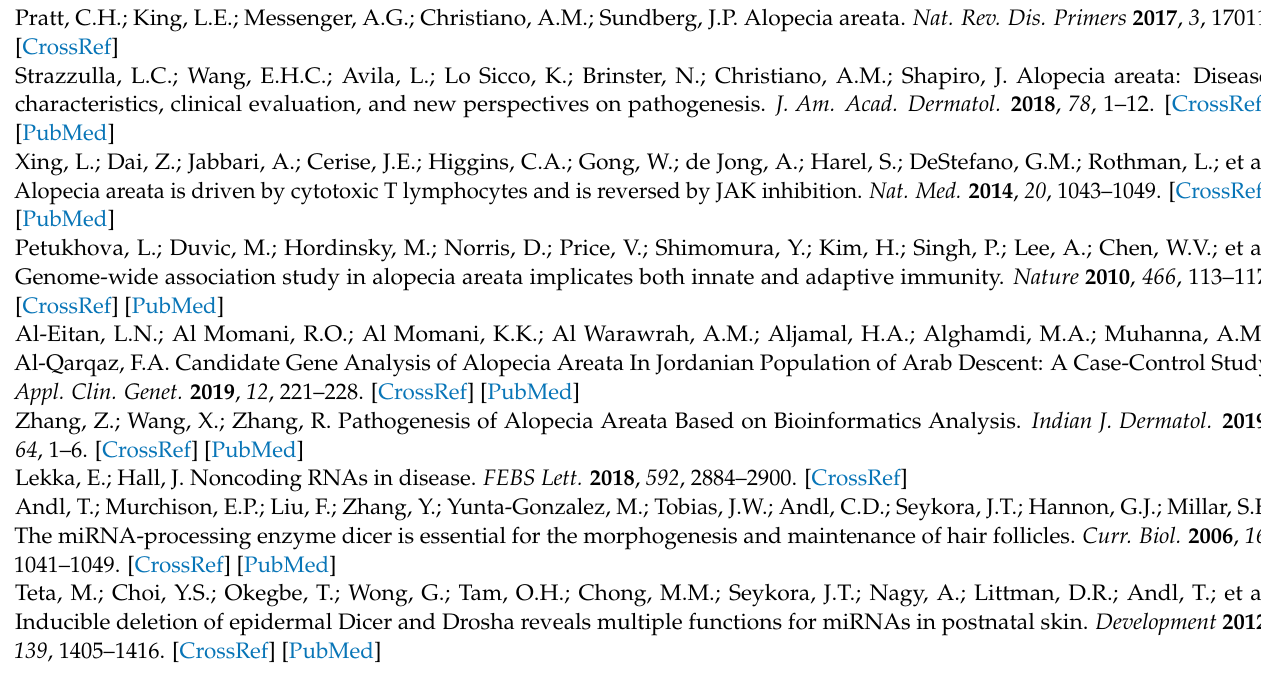
with clinical features; Table S4: Functional impact of MIR17HG polymorphism on regulatory re- gions. Figure S1. (A) Allele discrimination plot (single-nucleotide polymorphism assay, rs4284505) using TaqMan genotyping polymerase chain reaction (StepOne Real-Time; Applied Biosystems, Thermo Fisher Scientific, Foster City, CA, USA). Alleles, such as homozygous A/A (lower right red cluster), heterozygous A/G (middle green cluster), and homozygous G/G (upper left blue cluster), were retrieved using allele-calling software. The negative control samples were represented as black squares (x: undetermined) in the lower left corner of the plot. (B) Amplification plot for the quantification of MIR17HG by the Real-Time TaqMan ® PCR assay showing the of change in gene expression plotted vs. the PCR cycle number. This plot was obtained from the AB 7500HT instrument (Applied Biosystems,